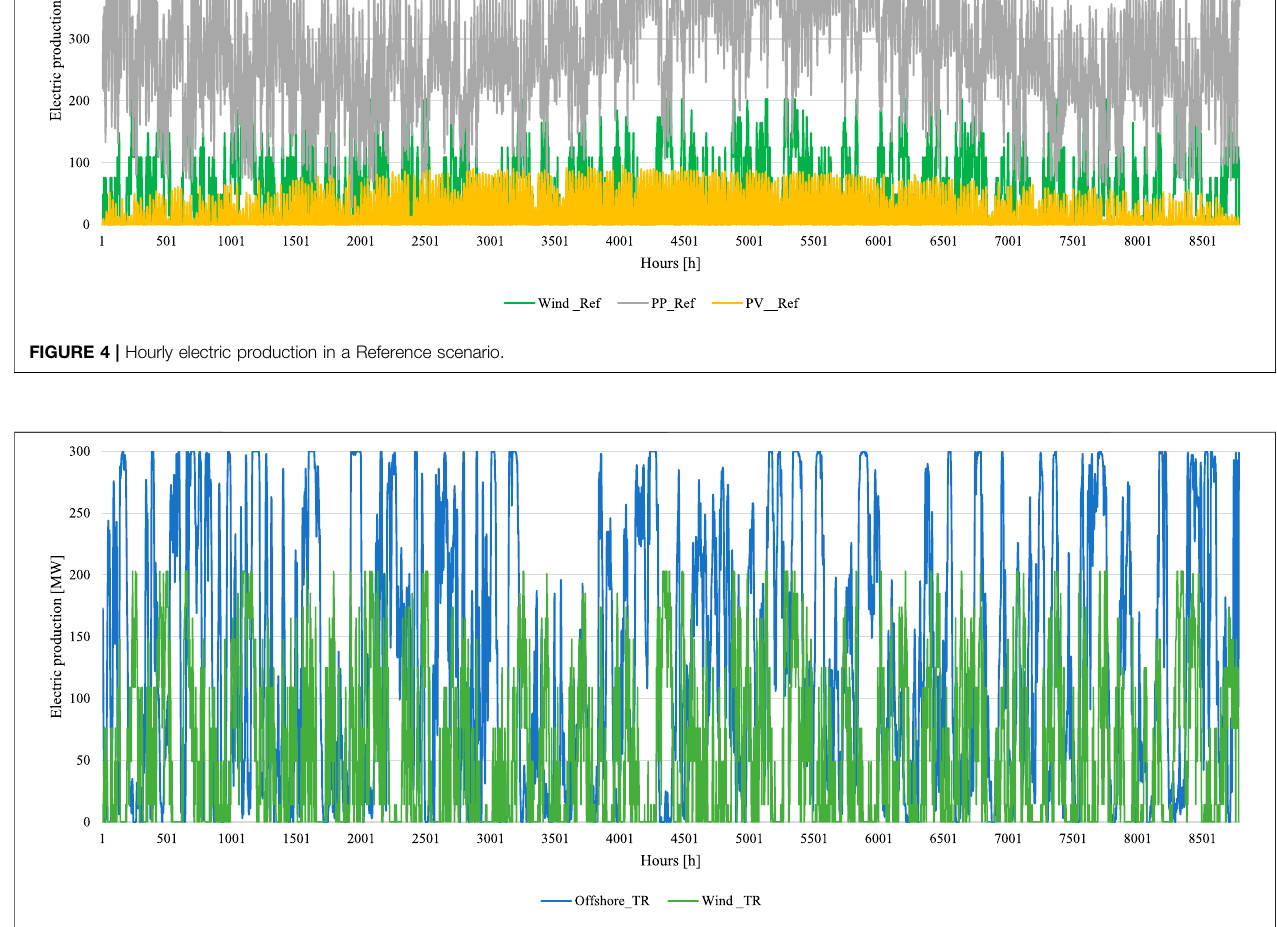
FIGURE 5 | Comparison of electricity production from offshore and onshore wind for a one-year